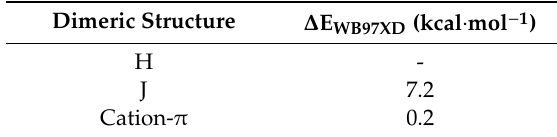
Table 2. Single-point energy di ff erences among the dimers in water (PCM) with WB97XD functional and 6-31G(d) basis set. Geometry optimization performed with WB97XD functional 6-31G(d) basis set, with CP, in the